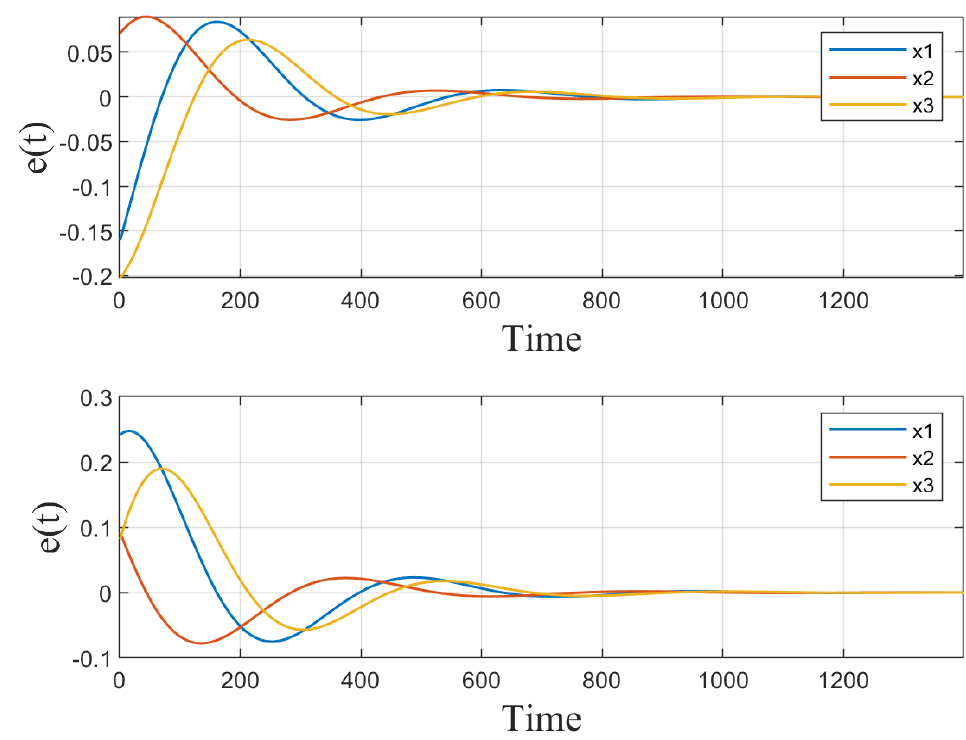
Figure 4. State error between